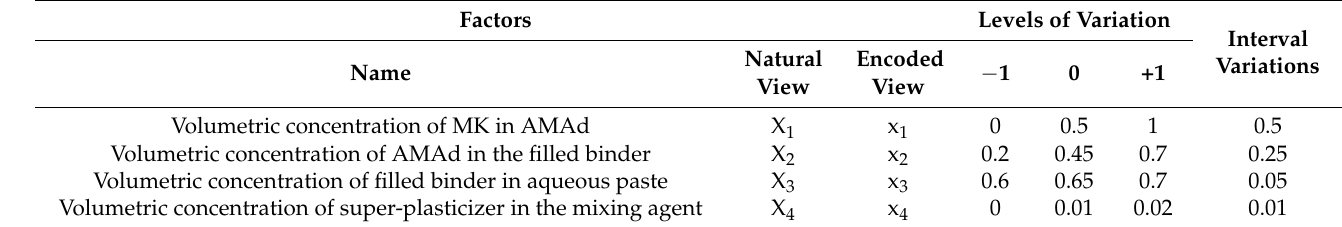
Table 3. Conditions for planning experiments in the study of effective